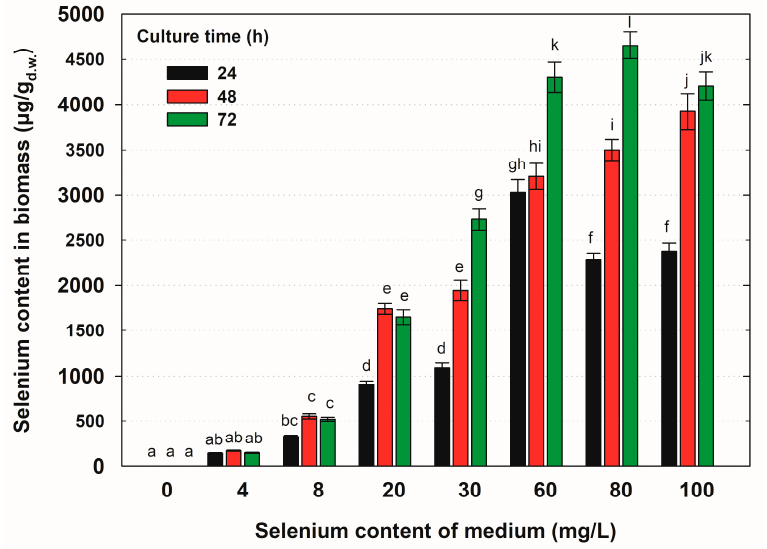
Figure 2. Changes in the content of selenium ( µ g / g d.w. ) in the cell biomass of C. utilis yeast after cultivation in the control (YPD) and in the experimental media enriched with selenium in the form of Na 2 SeO 3 . a − l Means with the same letter did not differ significantly ( p < 0.05). The results obtained indicate the ability of C. utilis ATCC 9950 yeast cells to accumulate